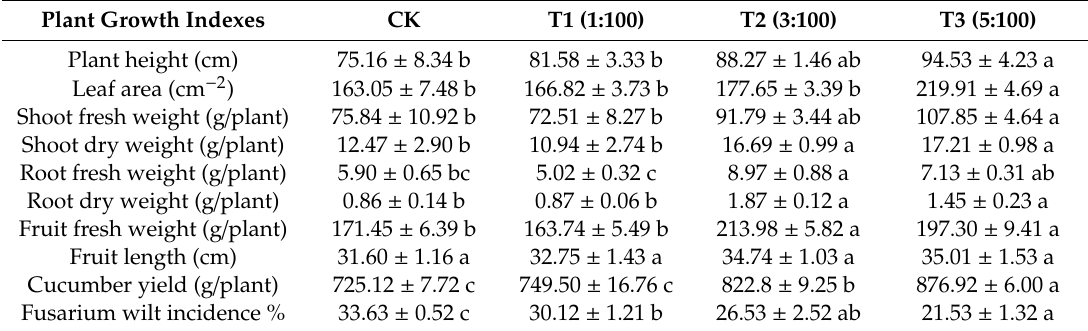
Table 1. E ff ect of di ff erent concentrations of garlic substrate on plant growth, fruit yield and Fusarium wilt incidence